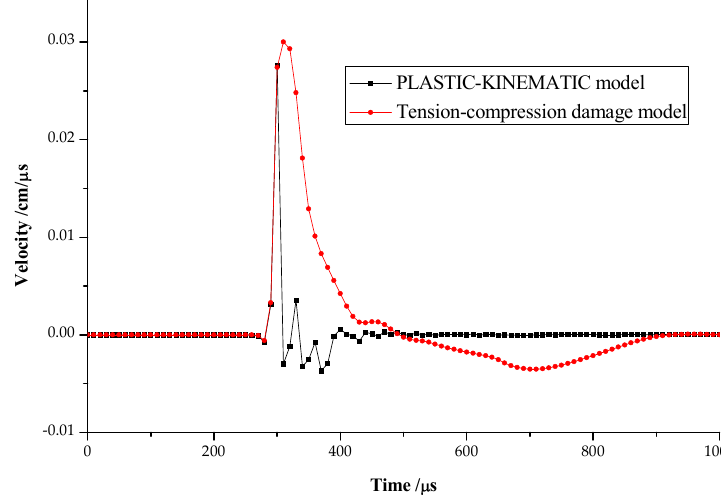
Figure 6. Acceleration–time curves for monitoring point 2.